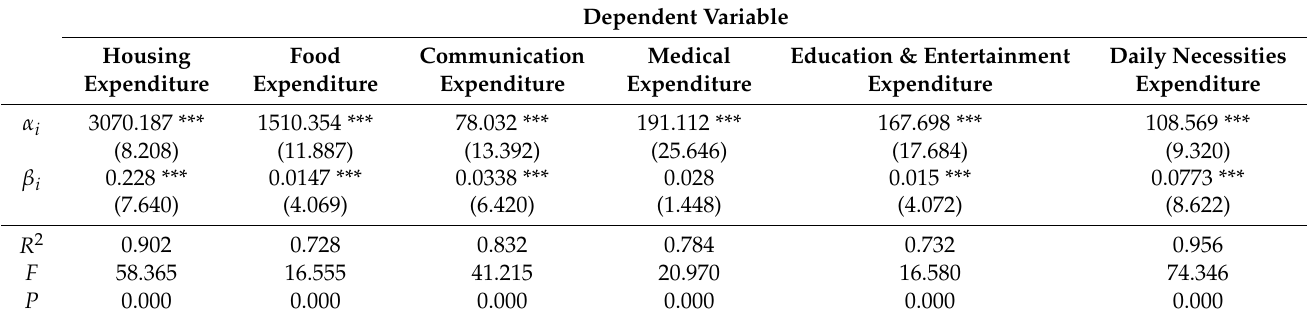
Table A2. Linear regression results of urban resettled in 2016.